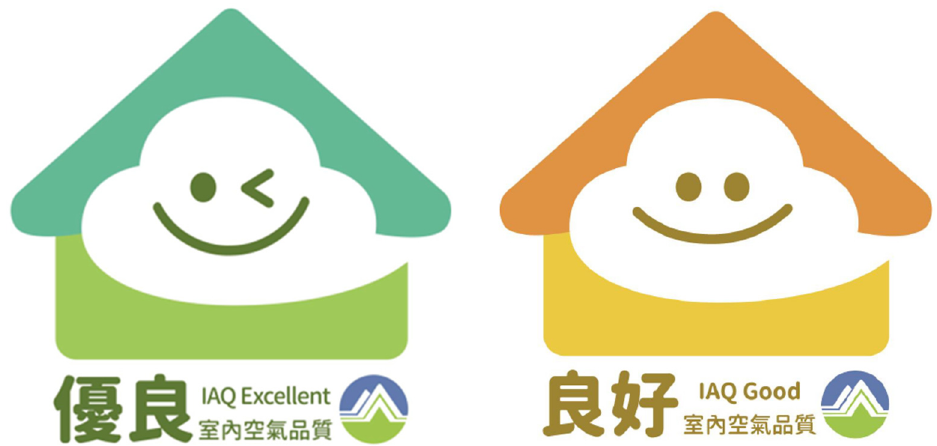
Figure 1. IAQ certification mark in Taiwan. Table 4. Selected cases of the IAQ certification standard in